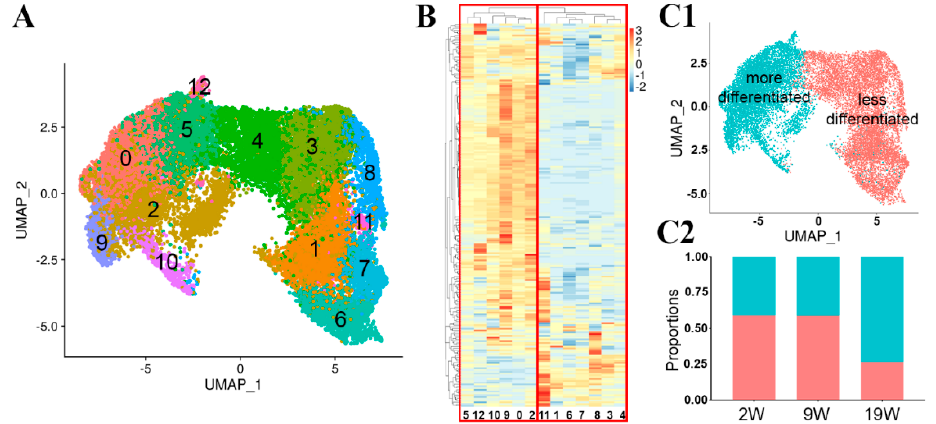
Figure 1. Heterogeneity of cultured human primary fetal RPE cells revealed by single-cell transcrip- tome analysis. ( A ) UMAP reduced dimensionality plot labelled with the thirteen clusters identified within the RPE cells. ( B ) Hierarchical clustering based on RPE-specific genes showed that the thirteen clusters partitioned into two distinct branches. ( C1 ) UMAP replotted to indicate more (green) and less (red) differentiated RPE cells. ( C2 ) The proportion of more differentiated cells increased after 19 weeks in culture (blue represents more differentiated cells, orange less differentiated cells). 2W-2 weeks; 9W-9 weeks; 19W-19 weeks in culture.